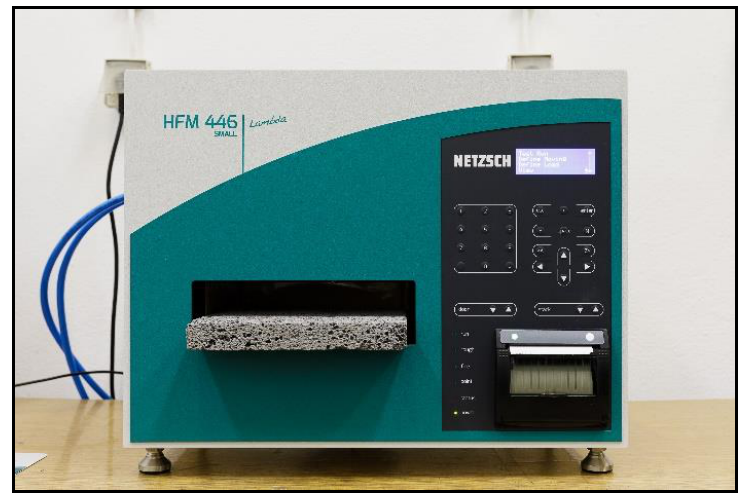
Figure 2. HFM 446 Lambda Series—Heat Flow Meter for Testing Insulation Materials.